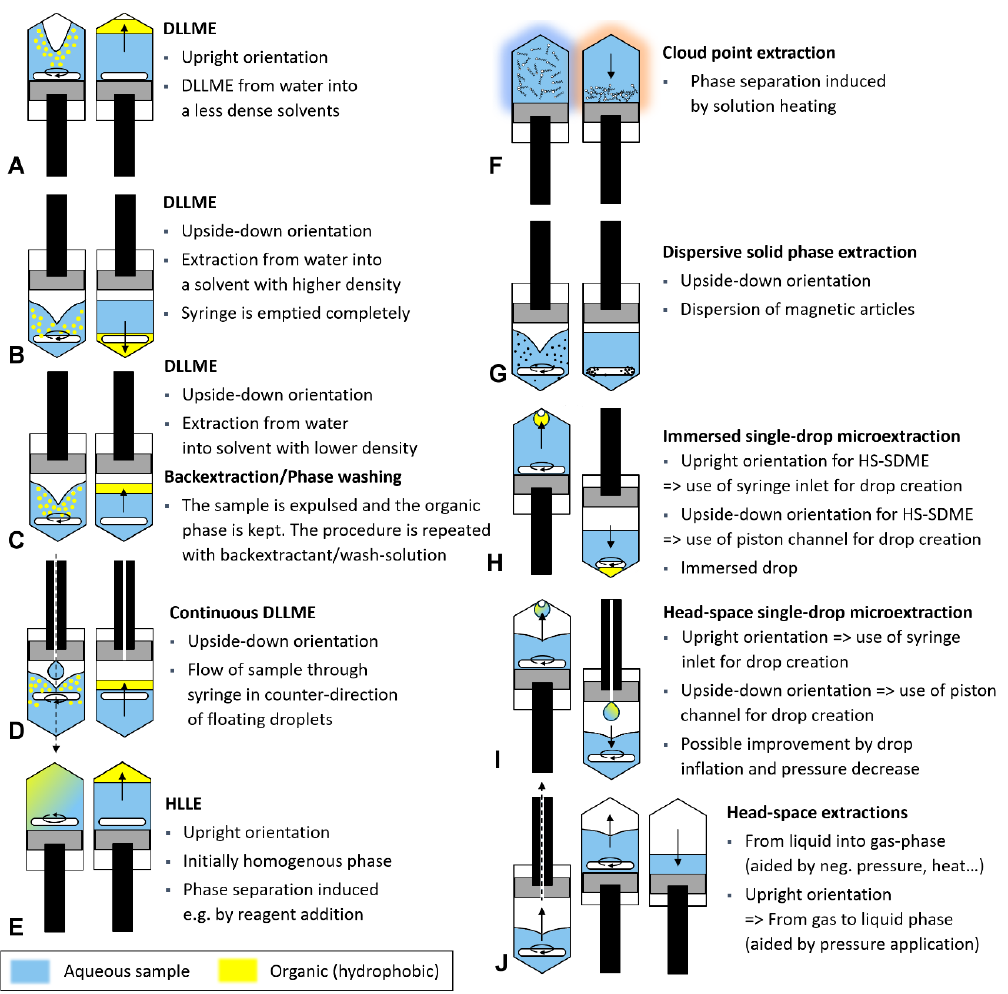
Figure 2. Overview of sample pretreatment procedures automated by Lab-In-Syringe with in-syringe stirring. In A – G , the left scheme indicates the extraction phase while the right one shows phase separation, in H – J , different modes of a similar methodology or operation are shown. Black arrows indicate the direction of analyte transfer, dotted back arrow indicate flow.